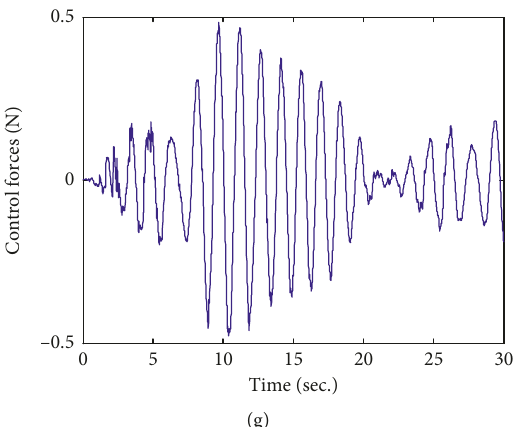
0 . 02. (a) Earthquake accelerations; (b) SRSS according to β and c (cid:29) 1 . 15 and c 1 . 15; (d) dynamic responses (3 rd (cid:29) (cid:29)